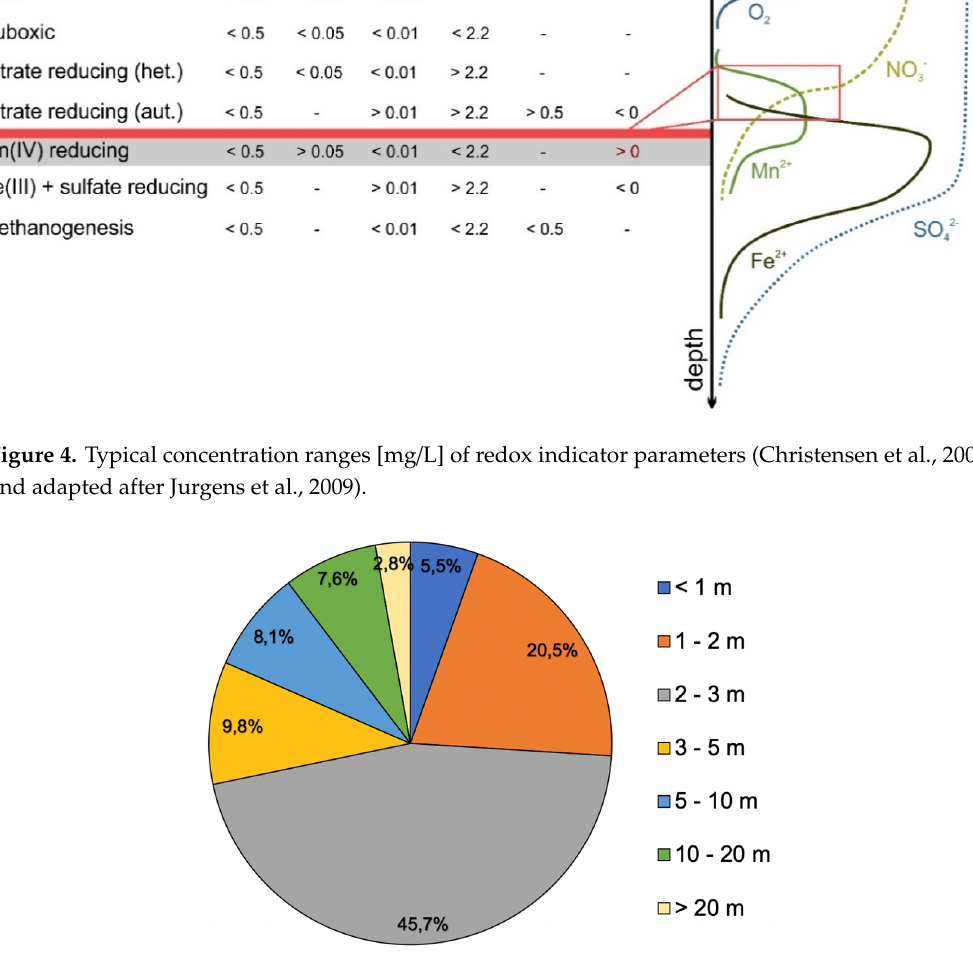
Figure 5. Percentage distribution of length of the monitoring screens in Lower Saxony in classes.